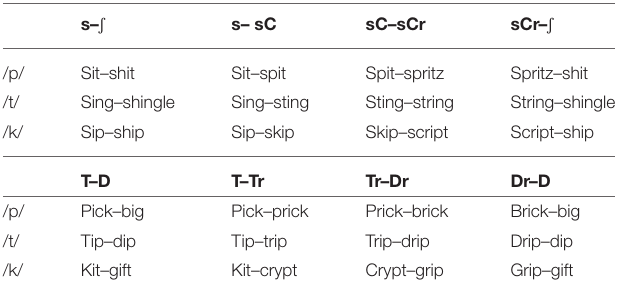
TABLE 1 | Scaling factors used in stimuli creation. TABLE 2 | Pairing of visual images organized by place of articulation and onset